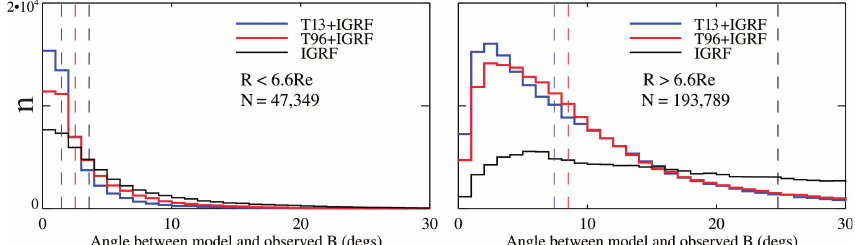
Fig. 15. Histograms of the angular difference between the observed and model vectors of the total magnetic field, based on the multi-spacecraft modelling data set displayed in Fig. 12. Red, blue, and black lines correspond to the T96, T13, and zero external model field. The left and right panels show results for the inner ( R < 6 . 6 R E ) and outer ( R > 6 . 6 R E ) magnetosphere, respectively. The corresponding median values are shown by the vertical dashed lines.